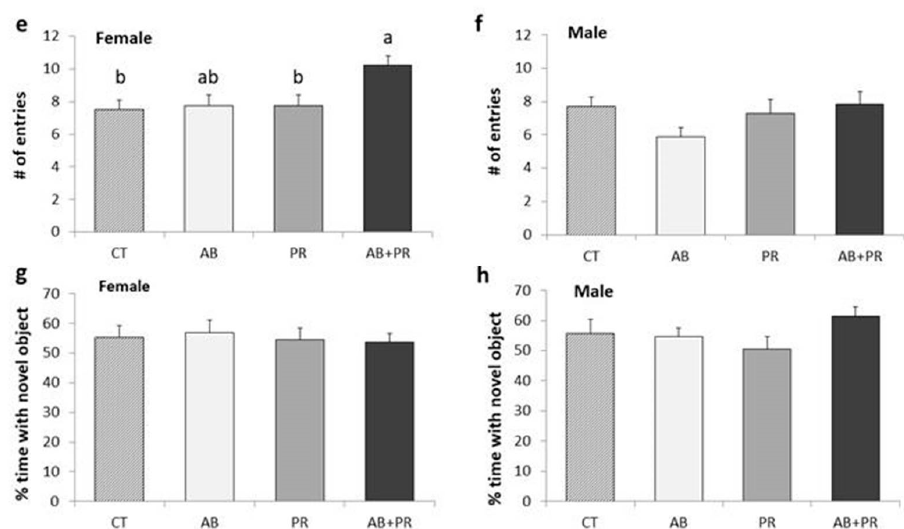
Figure 2. ( a ) Female total number of entries in open and closed arms; ( b ) male total number of entries; ( c ) female time in open arms; ( d ) male time in open arms; ( e ) female number of entries through open arms; ( f ) male number of entries through open arms; ( g ) female percent time with novel object; ( h ) male percent time with novel object. Values are mean ± SEM ( n = 10–13/group). Post hoc analysis is depicted with the superscripts a,b where groups without a common superscript differ ( p < 0.05) (i.e., a